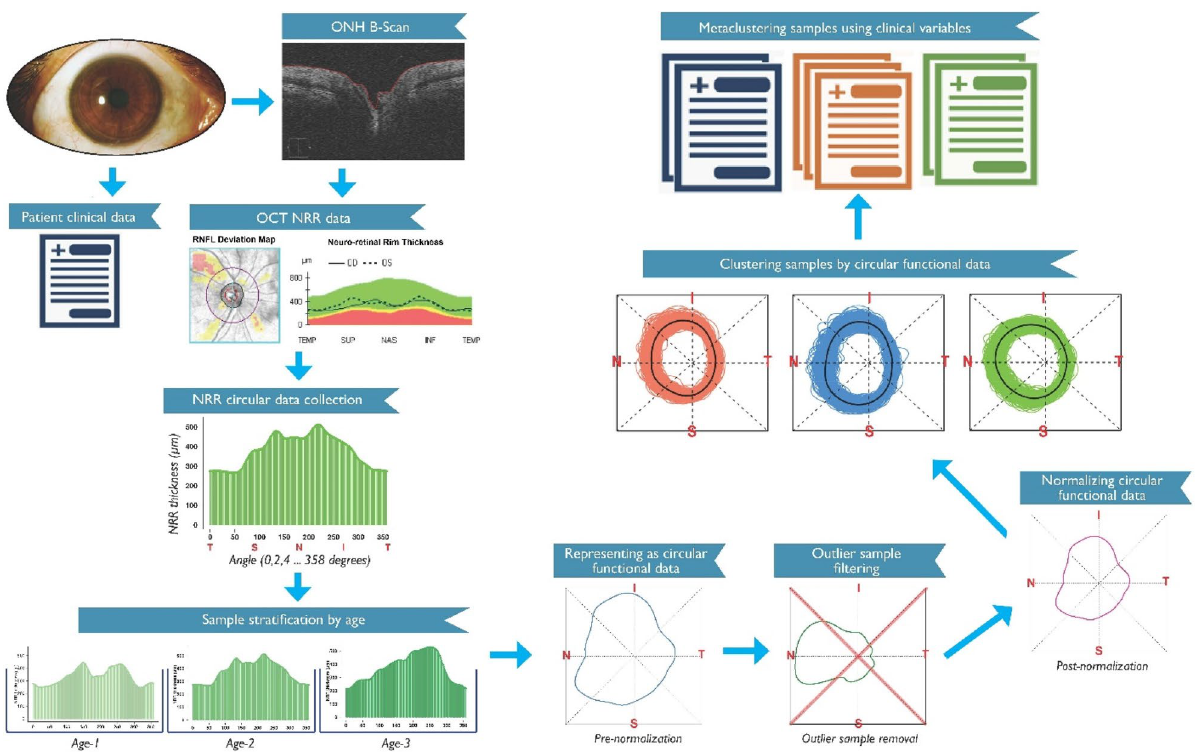
Figure 1. CIFU pipeline gives an illustration of each step including the collection of OCT NRR data and clinical data, representation as and clustering of NRR functional data, and metaclustering of clusters using clinical